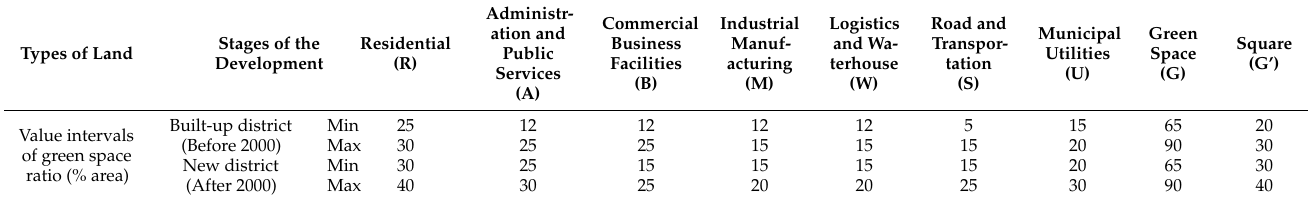
Table 2. The range of ratio of green space for nine types of land use in